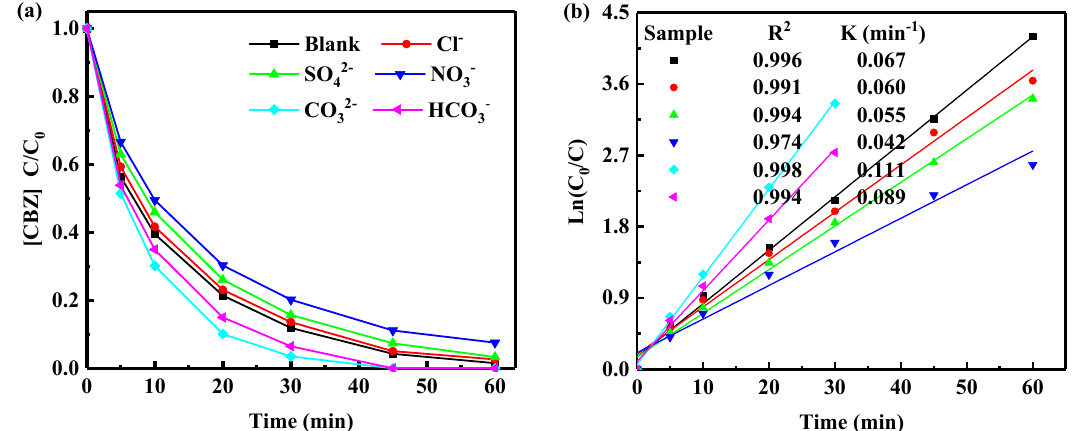
Figure 9. Degradation of CBZ by UV-LED/TiO 2 with different co-existing anions. 239 Figure 9. ( a ) Degradation of CBZ by UV-LED / TiO 2 in presence of di ff erent co-existing anions ( b ) 240 The pseudo-first-order kinetic models of CBZ degradation by UV-LED / TiO 2 in presence of di ff erent co-existing